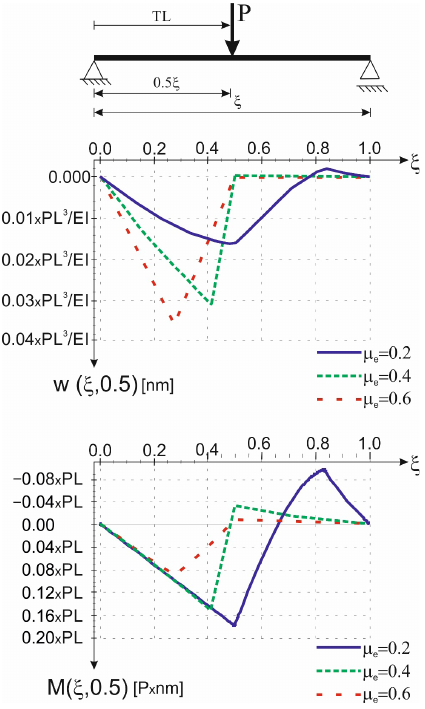
Figure 6: Stress gradient model. Displacement and bending moment of the beam for